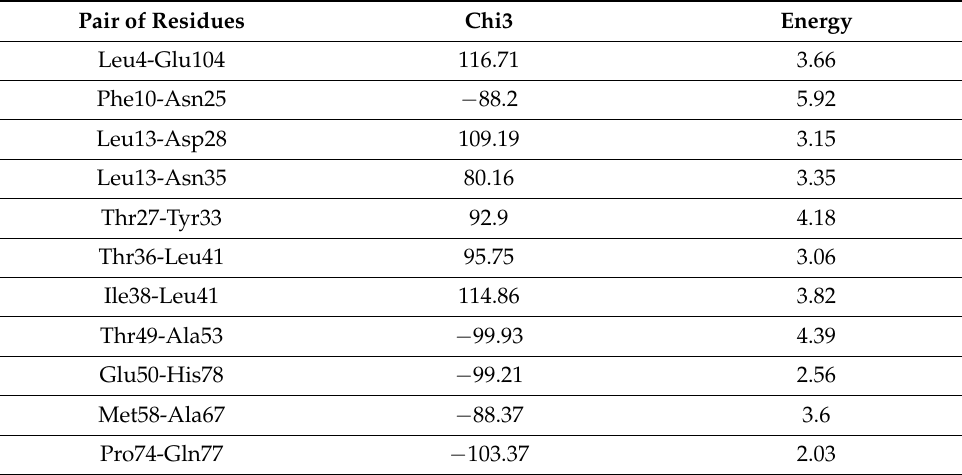
Table 7. The pairs of amino acid residues. Chi3 values and